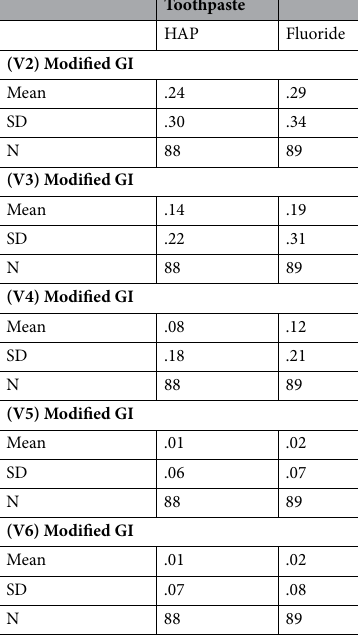
Table 6. Modified Gingival Index (GI) by toothpaste at visit 2 (baseline) to visit 6. SD, Standard deviation.